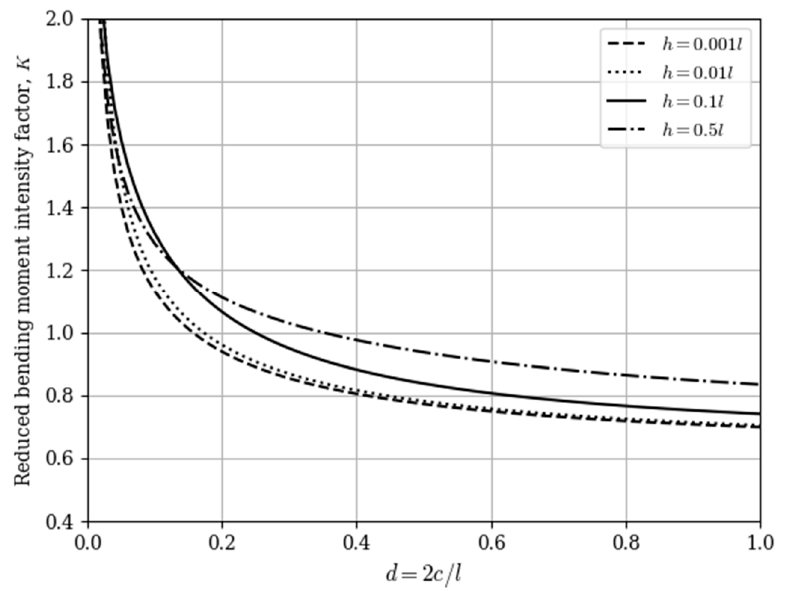
Figure 4. Dependence of the reduced moment intensity factor for inner crack tip on the distance between crack tips 2 / d c l = at = and various values of plate-thickness-to-crack-length ratio.